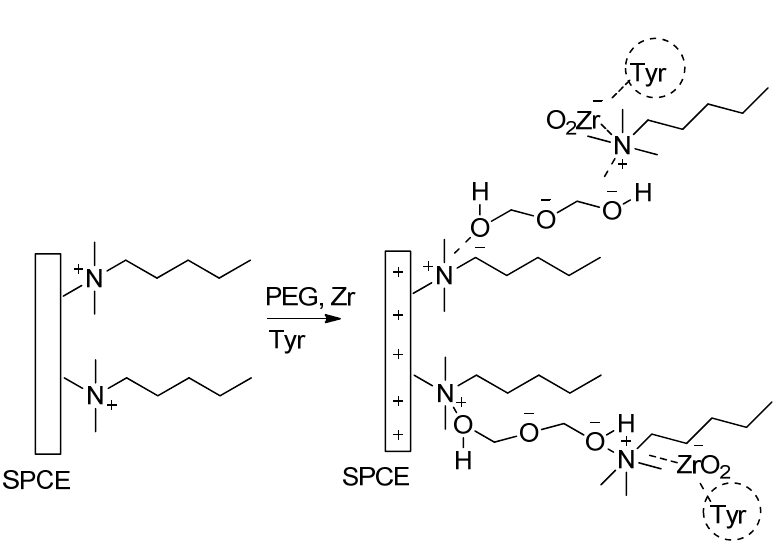
Figure 1. Possible assembling process of CTAB (hexacetyltrimethylammonium bromide)/PEG polyethylene glycol)-ZrO 2 /tyrosinase on screen printed carbon electrode. SPCE, screen printed carbon electrode.